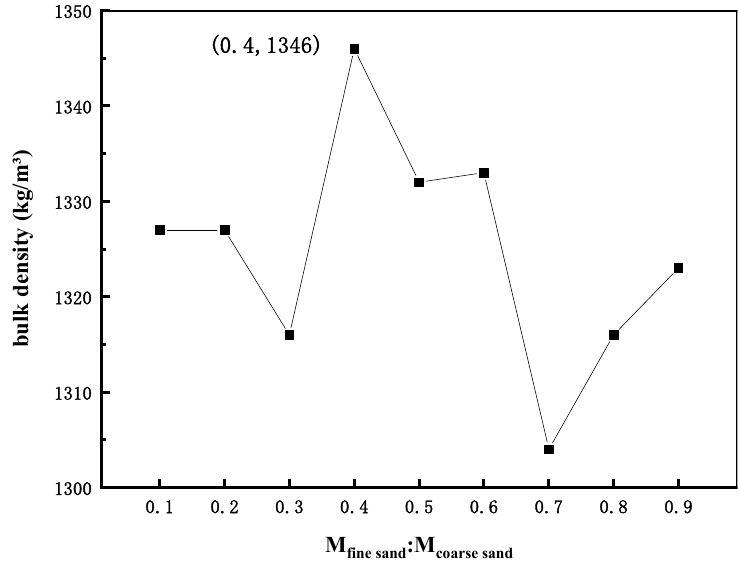
Figure 2. Bulk density test of sand.